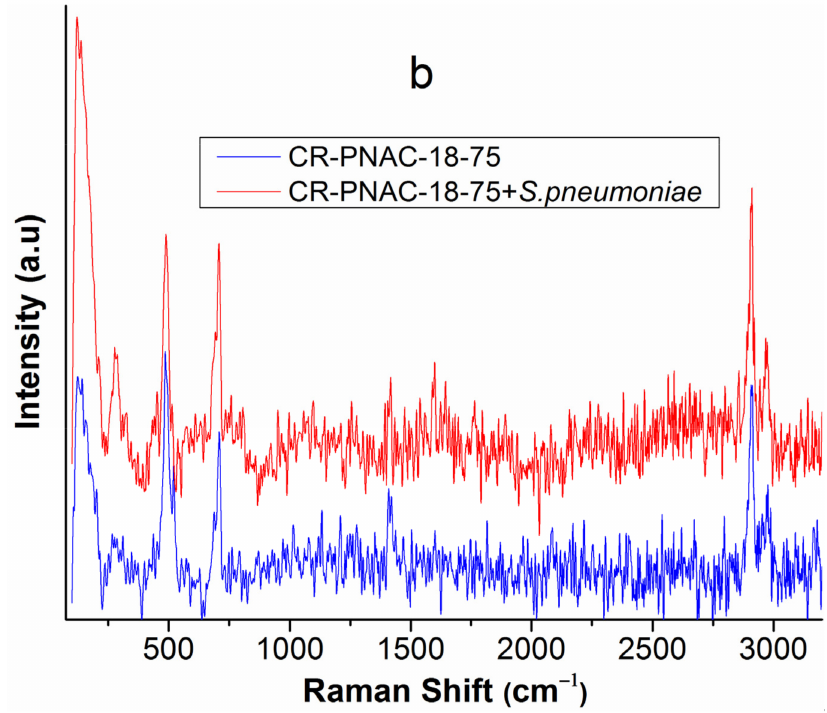
Figure 7. Raman spectra of ( a ) CR-PNAC-18-0 and ( b ) CR-PNAC-18-75 before and after bacterial